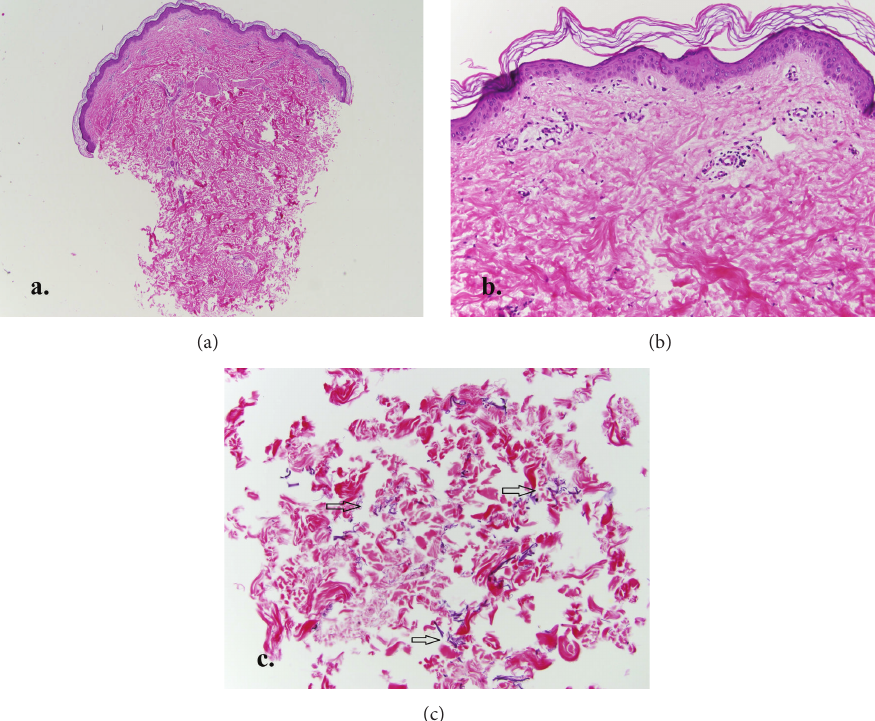
Figure 2: (a) Scanning magnification of a punch biopsy of lesional skin reveals a slightly attenuated epidermis, but otherwise unremarkable skin (H&E, 40x). (b) High power view reveals a nonspecific sparse perivascular lymphocytic infiltrate (H&E, 200x). (c) Elastic fiber stain demonstrates fragmented, elastic fibers in the midreticular dermis (arrows); Verhoeff-Van Gieson stain,